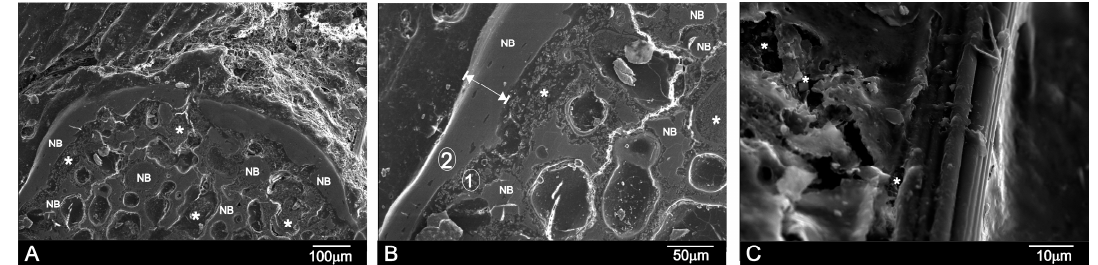
Figure 6. ( A , B ) SEM images of the cross-section of Nurse’s A implant in bone after 60 days of implantation; ( C ) A vessel present on the surface of the new bone layer in contact with the degraded Si-Ca-P material. Letters NB refer to the new bone tissue, while * refers to the Ca-Si-P particles as a result of the degradation process. Table 3. Ca/P ratio of the reaction zone 15, 30, and 60 days after implantation. Mean ± SD (Median). Time of Implantation